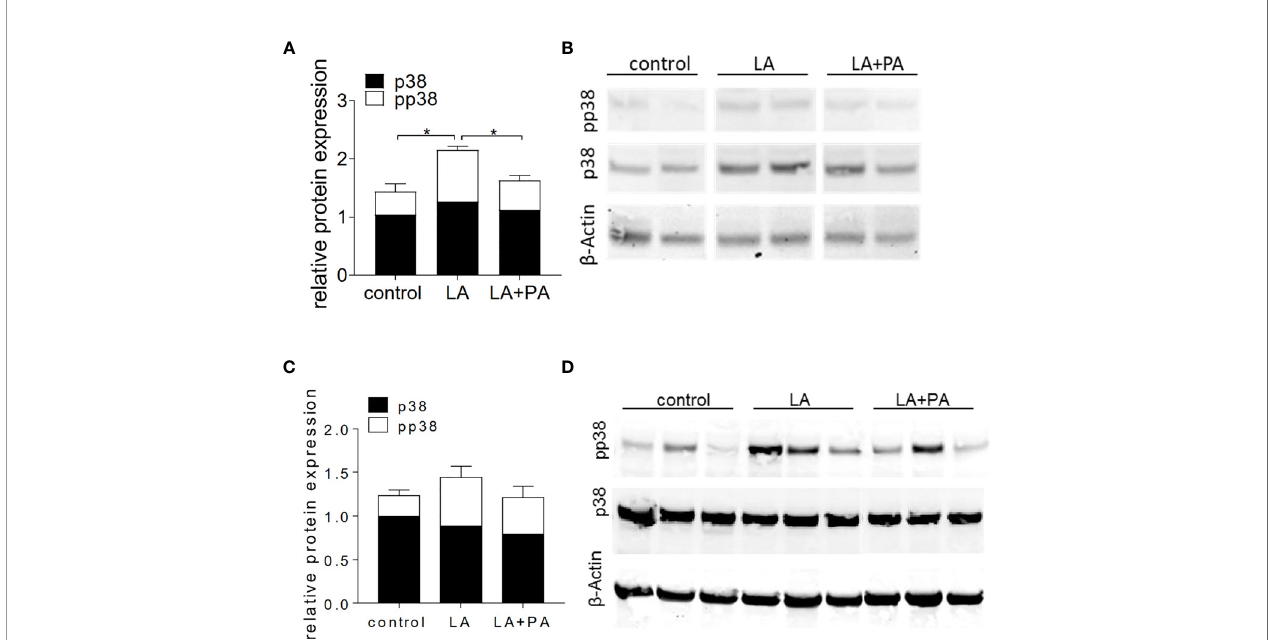
FIGURE 4 | PA decreases the LA-induced phosphorylation of p38-MAPK in the spleen and the small intestine. Mice were fed a LA-rich diet or control-diet 4 weeks prior to immunization and were additionally treated with PA (LA+PA) or water (control; LA) by daily oral gavage starting from day 0. (A, B) Western Blot analysis of p38 and phosphorylated p38 (pp38) from small intestinal LPL isolated on day 3 of EAE. (A) Quanti fi cation of p38 expression (black) and pp38 (white) in control, LA and LA+PA treated mice normalized to b -Actin expression. (B) Representative Western Blot images. (C, D) Western Blot analysis of p38 and pp38 from splenocytes isolated in day 10 of EAE. (C) Quanti fi cation of p38 expression (black) and pp38 (white) in control, LA and LA+PA treated mice normalized to b -Actin expression. (D) Representative Western Blot images. *p<0.05 using one-way ANOVA and Tukey ’ s posthoc